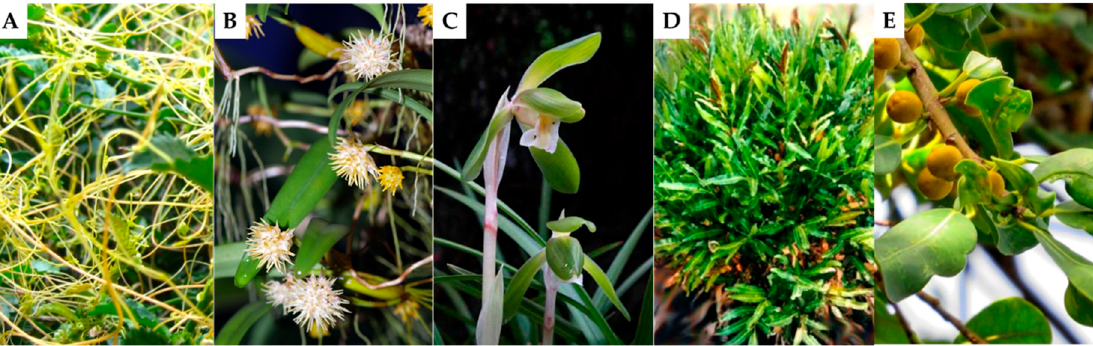
Figure 2. Five most popular medicinal epiphytes. ( A ) C. filiformis L. ( B ) B. odoratissimum (Sm.) Lindl. ex Wall. ( C ) C. goeringii (Rchb.f.) Rchb.f. ( D ) A. aureum Limme. ( E ) F. natalensis Hochst.